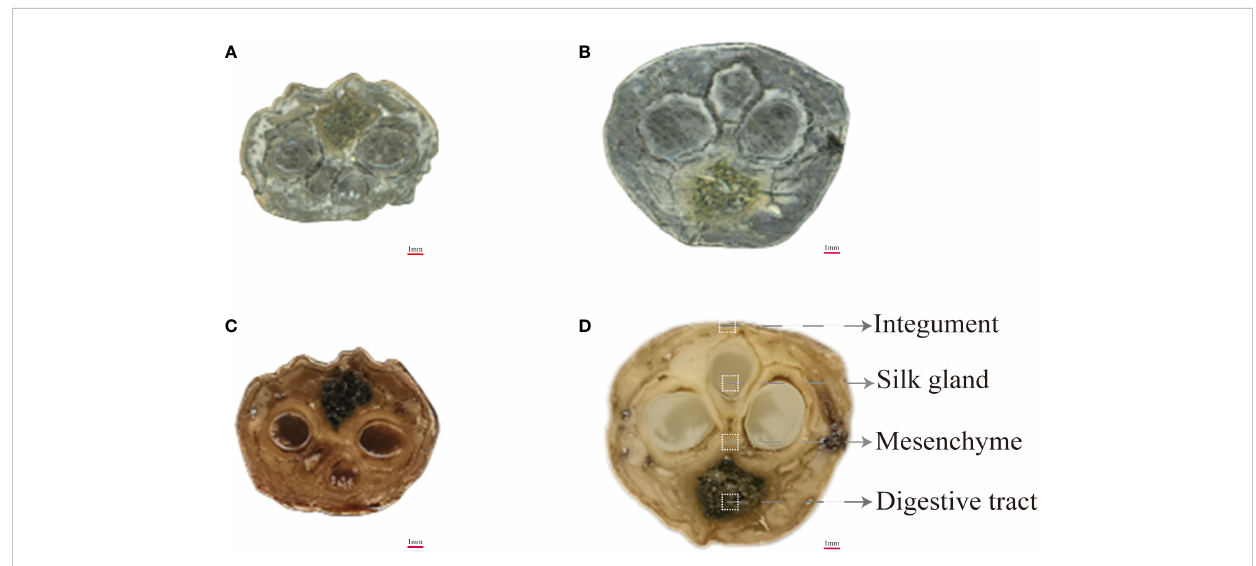
FIGURE 4 Cross-sectional optical images of raw and fried Bombyx batryticatus. (A, B) RBB. (C, D)